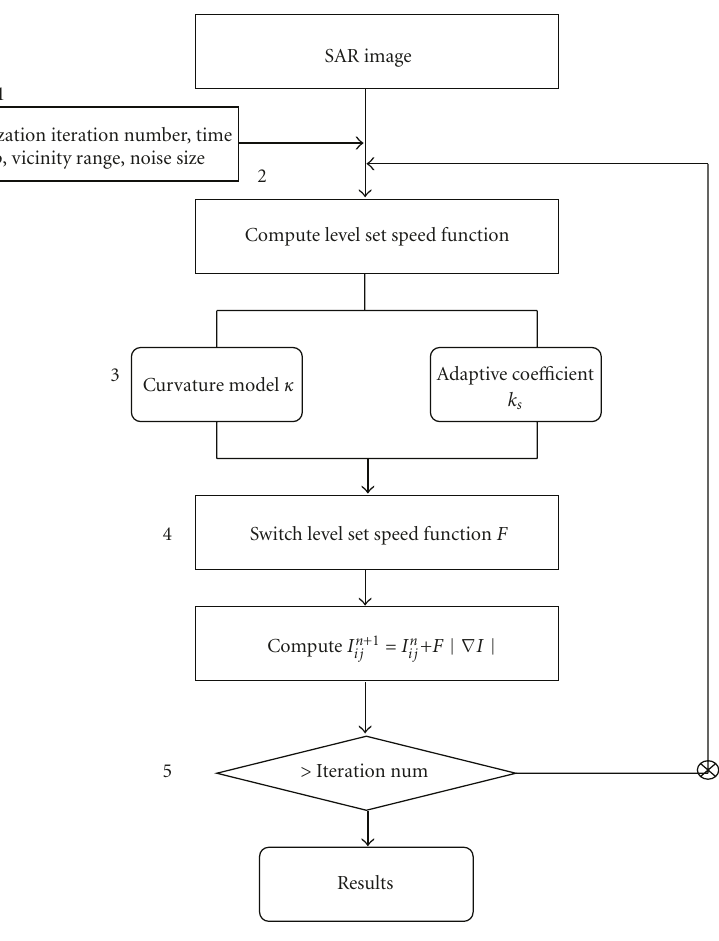
Figure 1: The framework for proposed level set